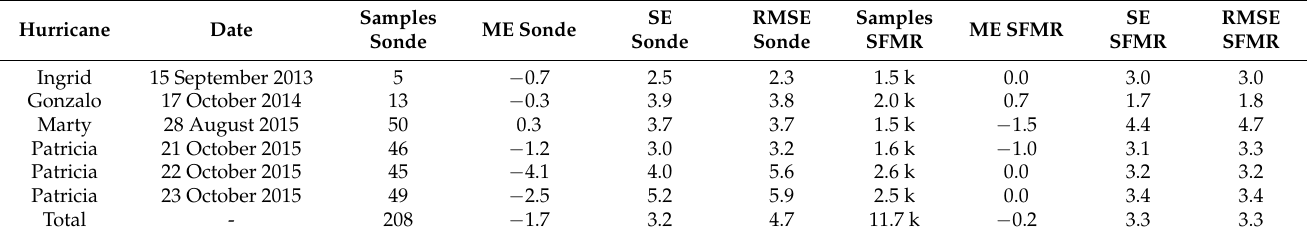
Table 4. HIRAD difference statistics with dropsonde and SFMR (reference–HIRAD) m/s, where the mean error (ME), standard error (SE), and root mean squared error (RMSE) are given for each.